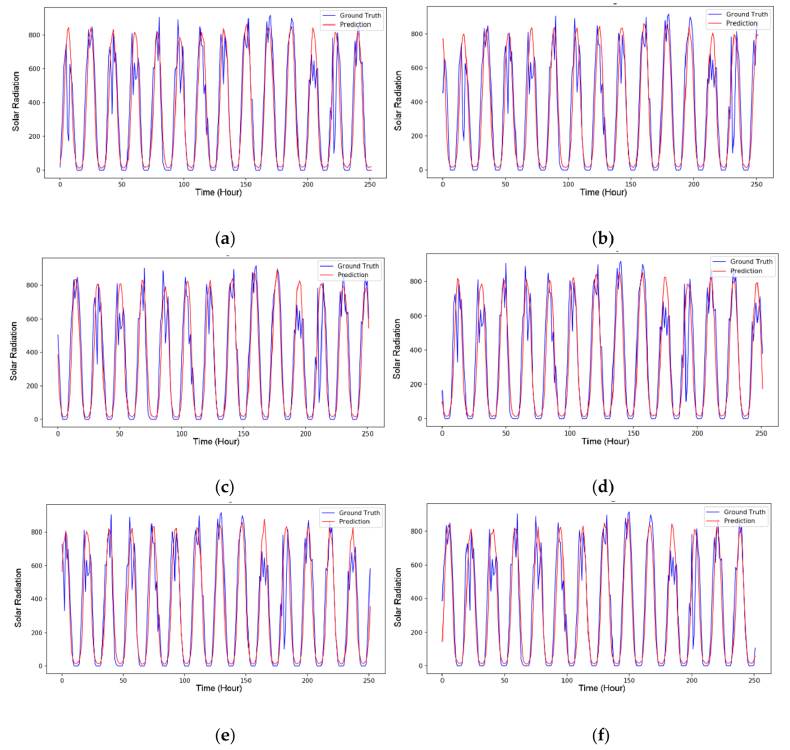
Figure 13. Forecasting results of long short term memory network: ( a ) Partial results A; ( b ) Partial results B; ( c ) Partial results C; ( d ) Partial results D; ( e ) Partial results E; ( f ) Partial results